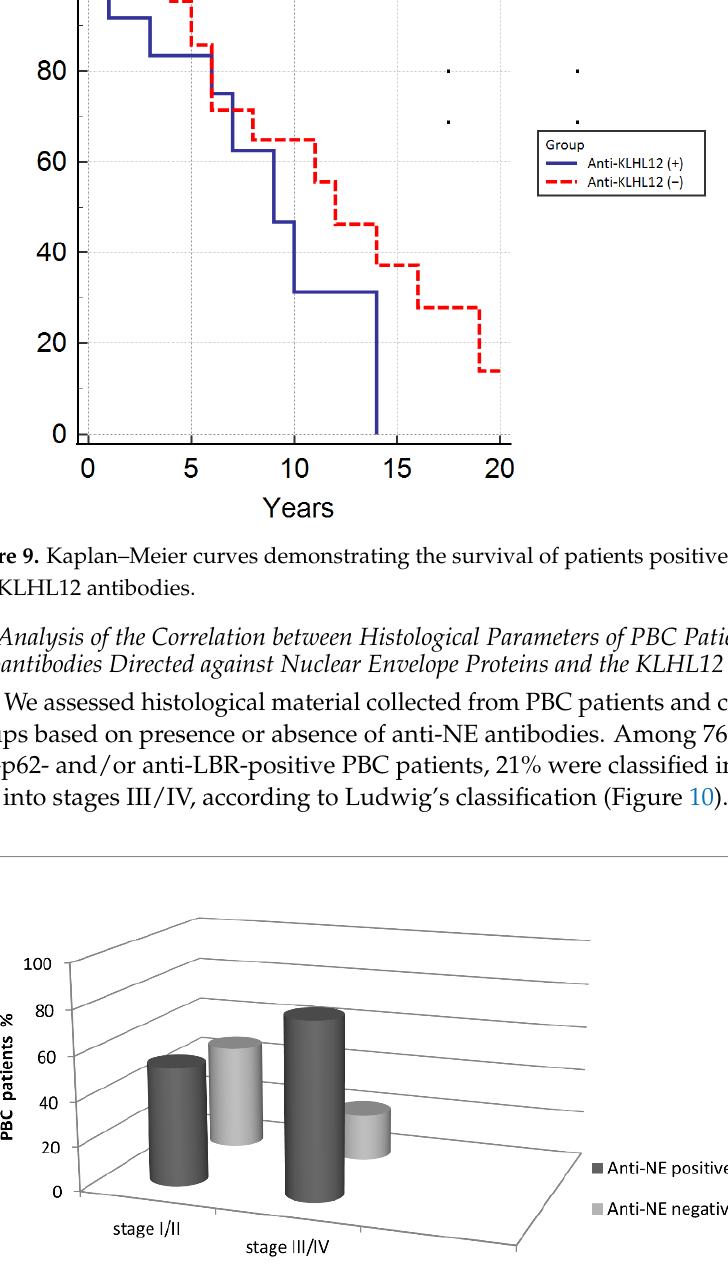
Figure 11. Presence of anti-KLHL12 antibodies and the stage of liver fibrosis in PBC patients. Among 82 PBC patients with early histological stages (I/II) of the disease, only 20 (24%) were positive for anti-KLHL12 antibodies. We found a statistically significant dif- ference in comparison to the group of PBC patients with advanced histological stages (III/IV), where 39 out of 52 (75%) subjects were positive for anti-KLHL12 antibodies ( p < 0.0001). 4. Discussion PBC is primarily characterized by presence of AMAs, with the most important anti- gens being PDC-E2, OGDC-E2, and BCOADC-E2 [11 – 13]. As non-invasive tests for iden- tification of autoantibodies as disease markers are useful for diagnosis of patients, we an-